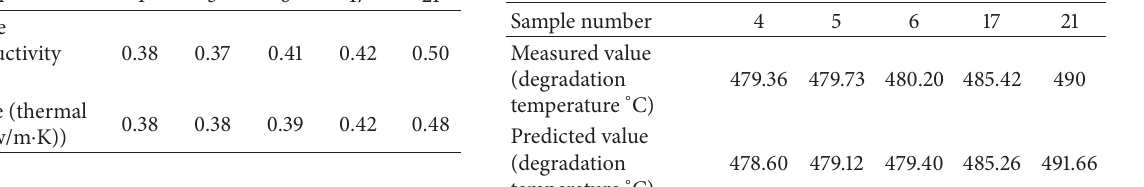
Table 5: Prediction results of crystallization temperature for test samples.